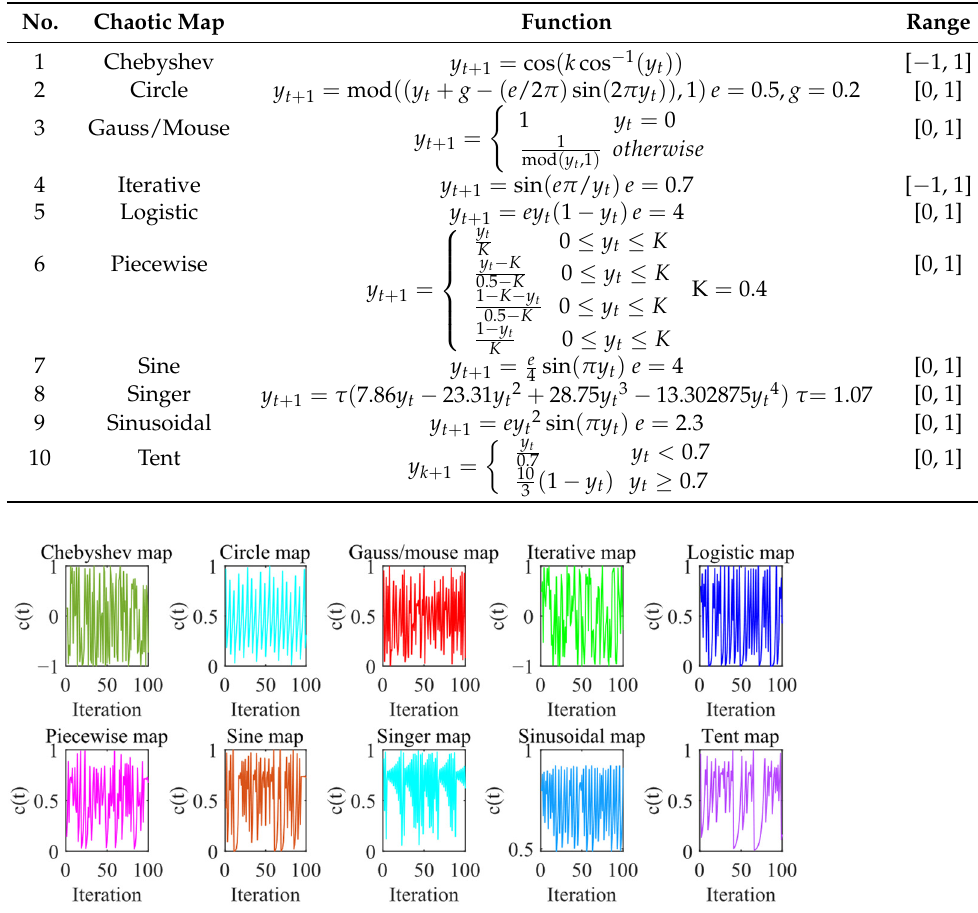
Table 1. The chaotic maps function.